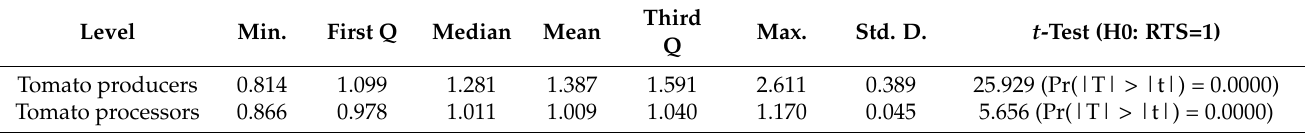
Table 4. Scale efficiency. Source: authors’